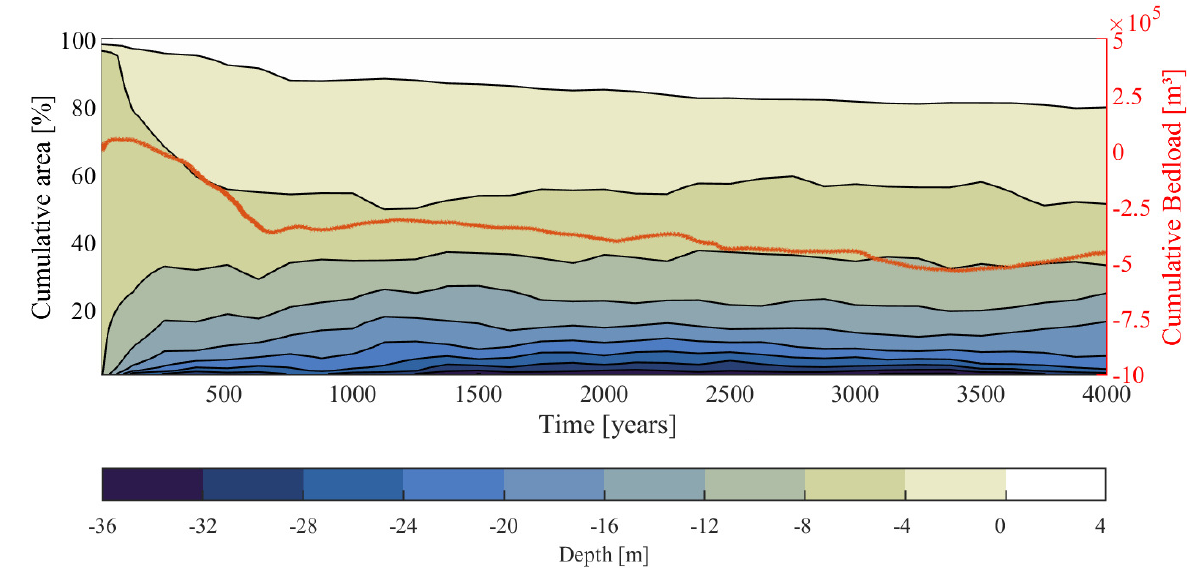
Figure 6. Development of the hypsometry over time in the area of interest ( left y -axis) combined with the cumulative bedload transport over time ( right y -axis). Both trajectories tend to become linear over time which is considered to prove morphodynamic equilibrium.